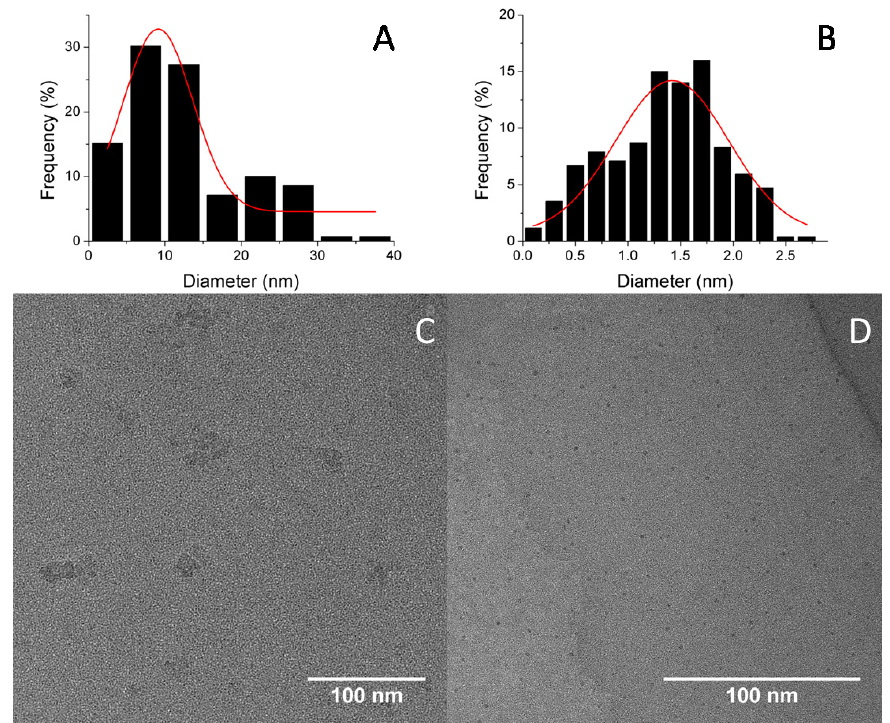
Figure 4. Size histograms ( A ) CS180, ( B ) CSU180 and the corresponding TEM images of as-synthesized CNDs ( C ) CS180, ( D ) CSU180, respectively.